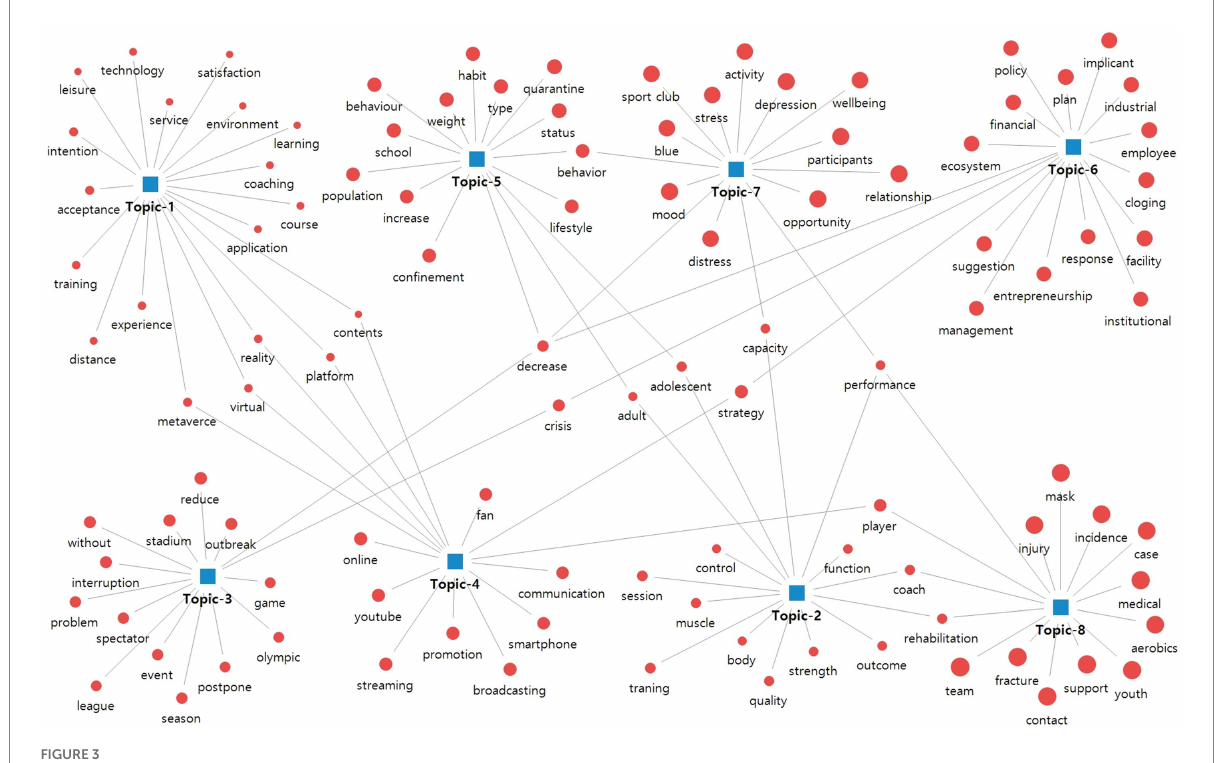
FIGURE 3 Semantic keywords network of topic